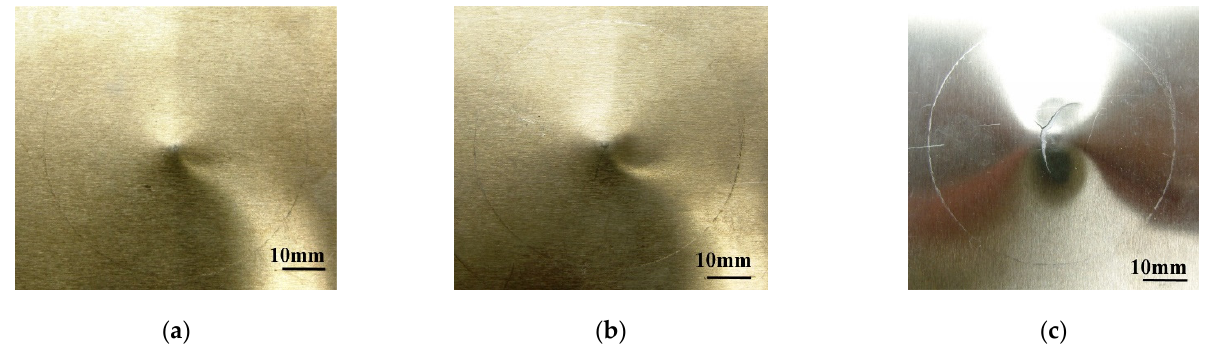
Figure 6. Multiple impact damage of aluminum 2024-T3 at ( a ) BVID (8 J (2 × 4 J)), ( b ) BVID (16 J (2 × 8 J)), and ( c ) CVID (26 J (2 × 13 J)).